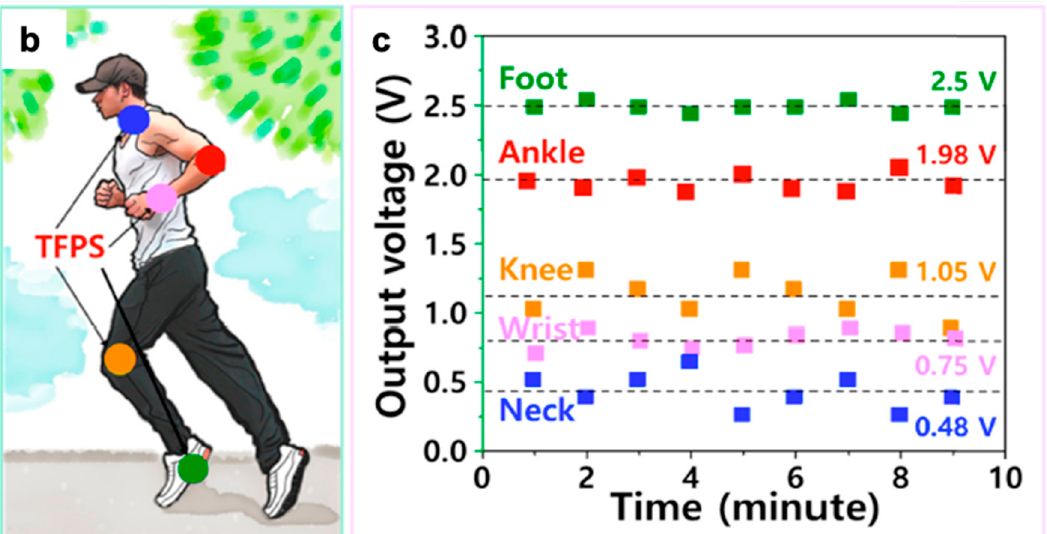
Figure 14. ( a ) Output voltage demonstration of TFPS with movement of foot, neck (voice vibration), wrist, and knee. ( b , c ) Schematic of device placement on a running individual along with stability tests at the corresponding locations. The statistical results were recorded nine times for 10 min under identical conditions. Reproduced with permission from [235]. Copyright Elsevier 2018.